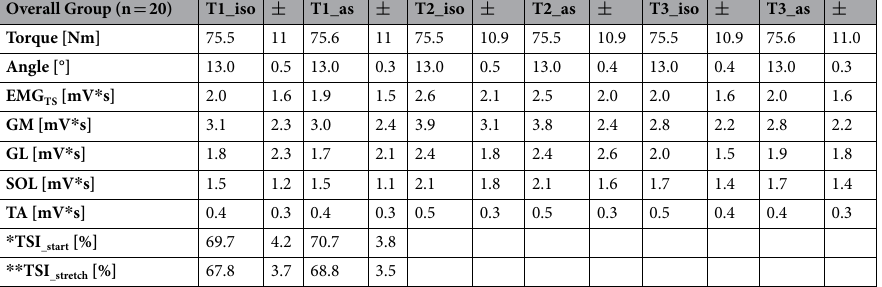
for EMG data the integral for each analysis section was computed using the trapezoidal numerical integration function of MATLAB.